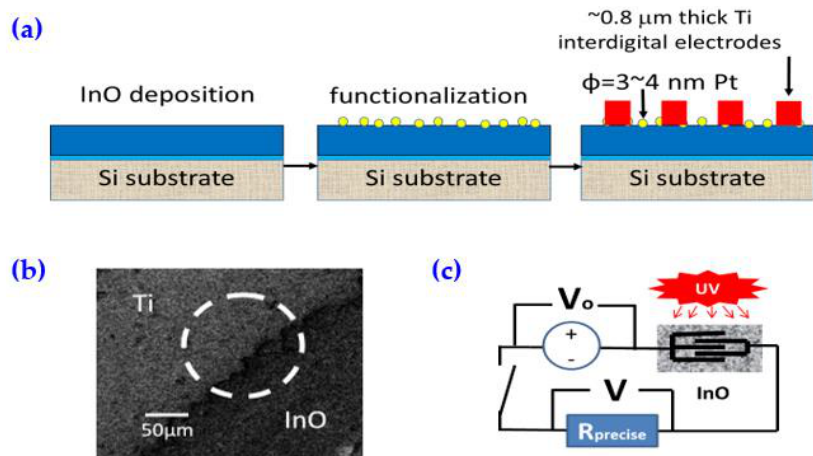
Figure 3. ( a ) Schematic diagram of the fabrication of the In 2 O 3 -based UV photodetector. ( b ) SEM image of the edge between the Ti electrode (grey) and sensing material (black) of the prototype. ( c ) Experimental setup for measuring electric properties and light responsivity of the UV photodetector.